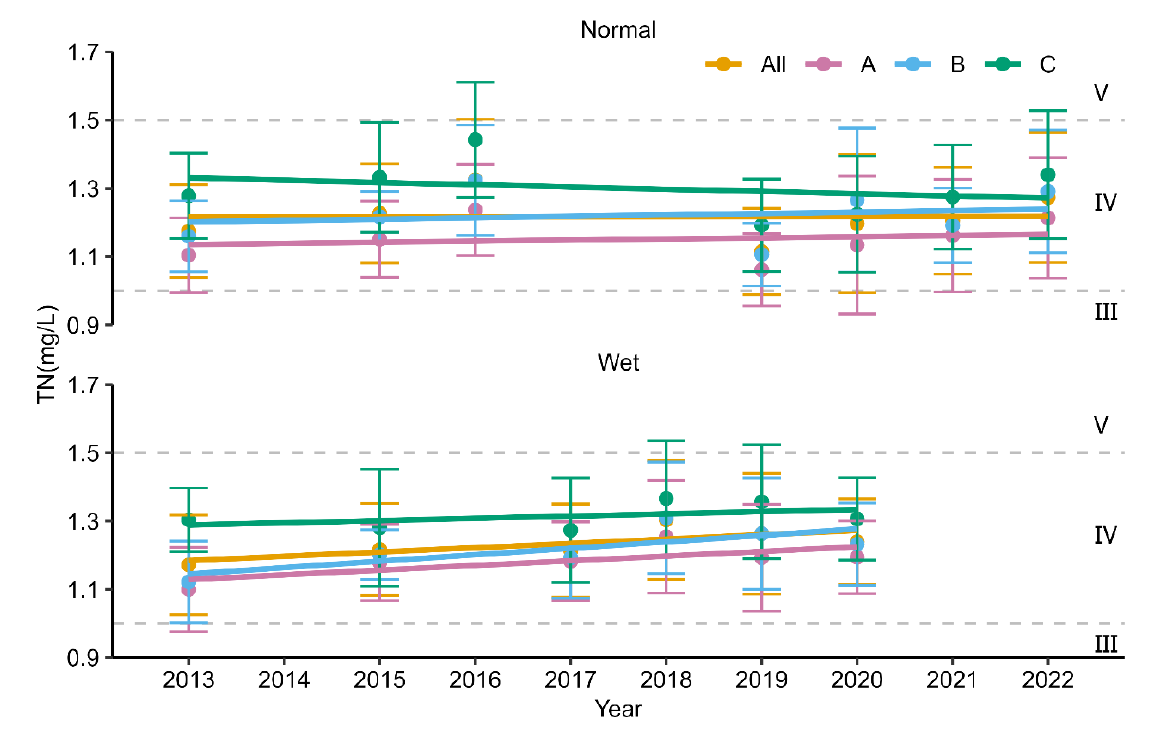
Figure 4. Time series of mean Landsat 8-monitored TN of the NRD in the whole region (All) and three subregions (A, B, and C) in the normal and wet seasons from 2013 to 2022. Ⅲ , Ⅳ , and Ⅴ are the quality standards for surface water from low to high.